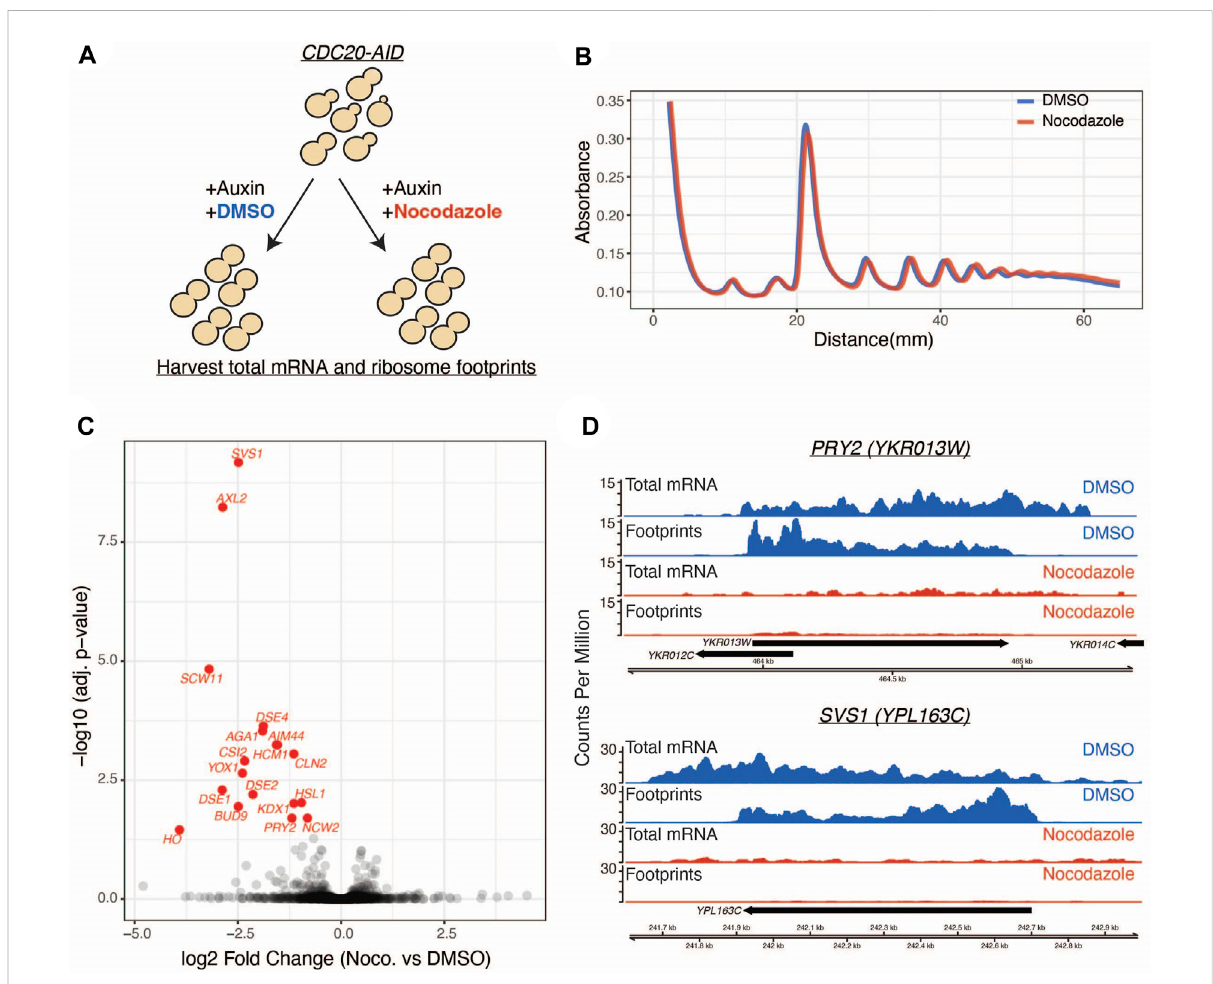
FIGURE 1 Ribosome pro fi ling reveals a nocodazole induced translational response. (A) CDC20-AID cells (SBY14004) were split into two conditions and simultaneously treated with auxin to arrest cells in metaphase and either nocodazole or DMSO. Lysates from these populations were used for ribosome pro fi ling and mRNA sequencing. (B) Polysome pro fi les generated from DMSO (blue) and nocodazole (red) treated cells. y-axis is absorbance at 254 nm and x-axis is millimeters (mm) from top of gradient. (C) Volcano plot of ribosome pro fi ling data. Log2 fold changes of total mRNA-normalized footprint abundance (nocodazole vs. DMSO) are plotted on the x-axis, and negative log10 multiple-test corrected p -values are plotted on the y-axis. Individual genes are represented as black dots, and signi fi cantly translationally regulated genes (Wald test, Benjamini Hochbergadjusted p < 0.05)arecoloredinred. (D) Genomebrowsertracksofribosomepro fi lingandmRNAsequencingdatafortworepresentative genes. Data from the DMSO control condition is shown in blue and nocodazole condition in shown in red. Aggregate (across all replicates) counts per million are plotted on the y-axis. Genomic coordinates are plotted along the